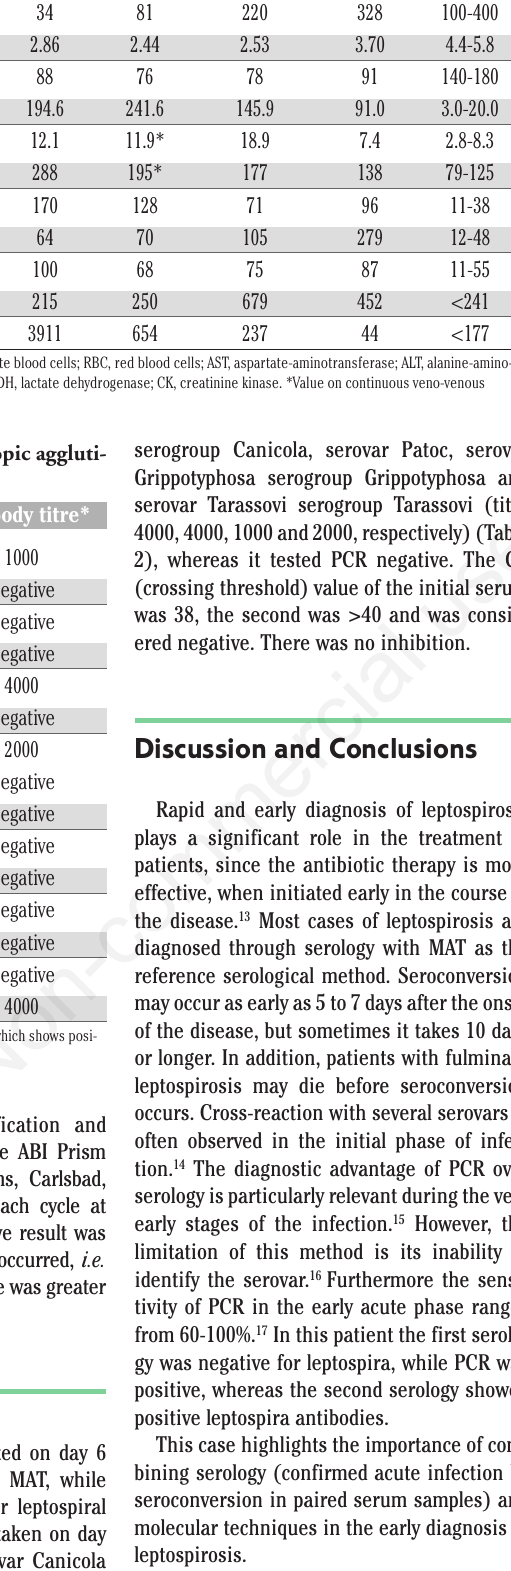
Table 1. Laboratory results demonstrating disease progression and regression.